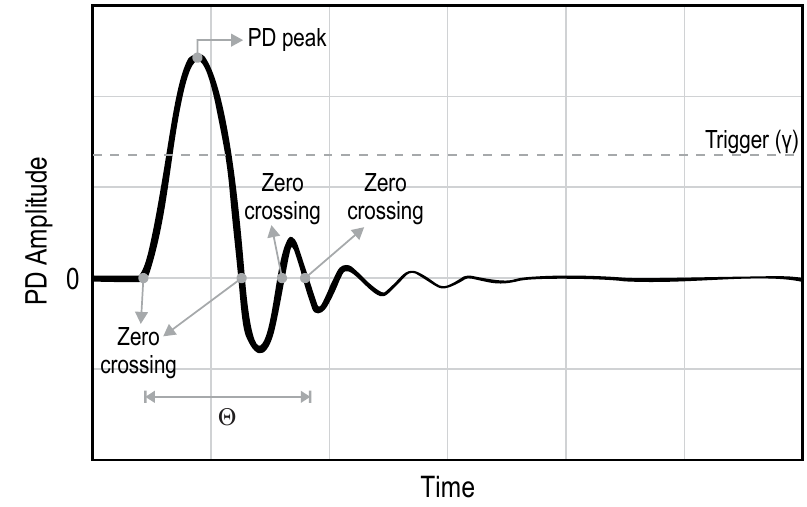
Figure 10. Identification of peaks of partial discharges.